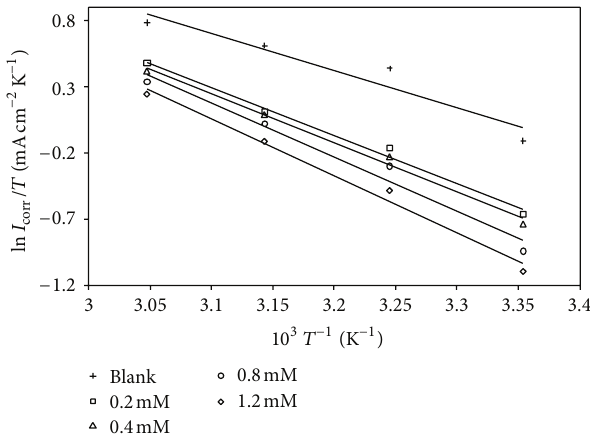
/𝑇) versus 1/𝑇 of 1M corr